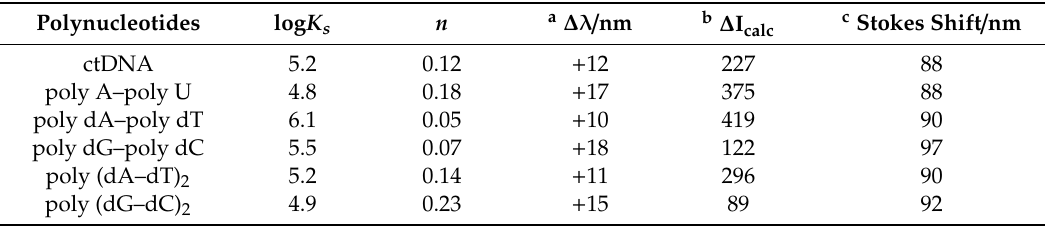
Table 2. Stability constants (log K s ), ratios n = [bound F1 ] / [polynucleotide] and spectroscopic properties of complexes of F1 with ds-polynucleotides calculated according to Scatchard equation by Global Fit procedure simultaneously from UV-Vis and fluorimetric